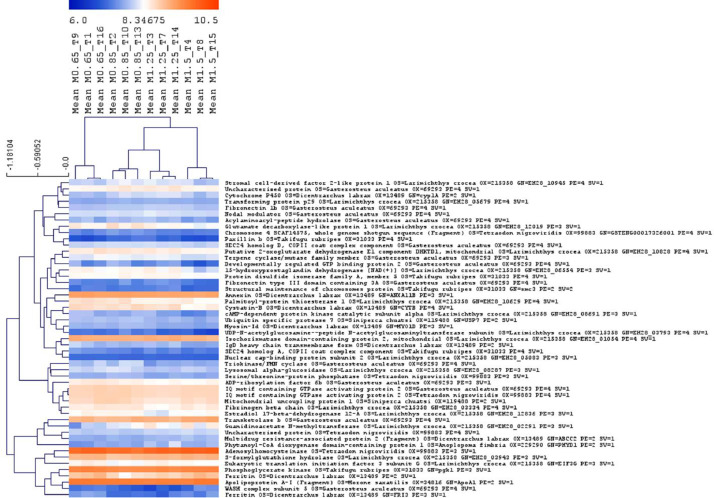
Hierarchical clustering analysis (HCL) after 18 days of feeding fish fed with Met-enriched diets. Clustering of fish samples and proteins with significant changes between treatments (One-Way ANOVA, p < 0.05). The mean values of protein abundance were obtained from 3 liver samples/tank and triplicate tanks per treatment are shown.